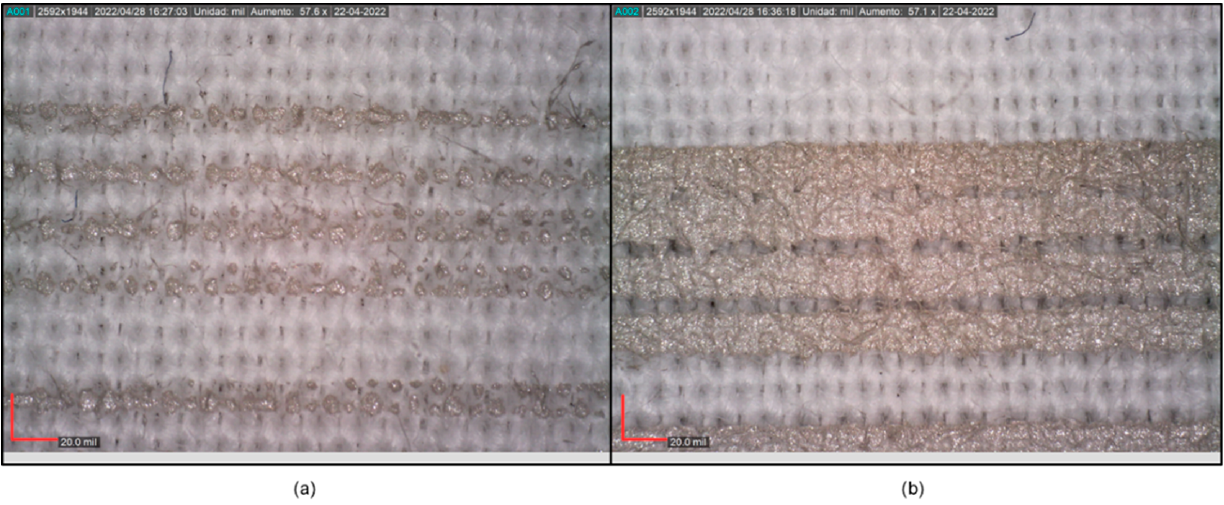
Figure 4. ( a ) Open circuit: 12 mil (0.305 mm) tracks printed using SCAG-005 ink with two printings using a mesh of 150 threads/cm; ( b ) short circuit: 12 mil (0.305 mm) tracks printed with SCAG-005 ink with four printings using a mesh of 130 threads/cm.